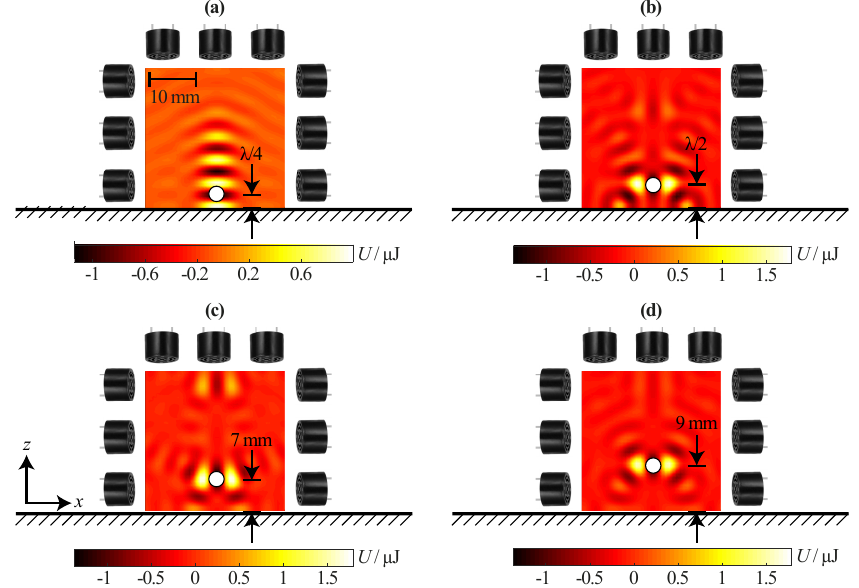
Figure 6. Force potential for ( a ) a standing wave with a minimum at z = λ /4, and VTTs at ( b ) z = λ /2, ( c ) z = 7mm, and ( d ) z = 9mm. The potentials are obtained for an acoustically reflective surface ( R = 1) at z =